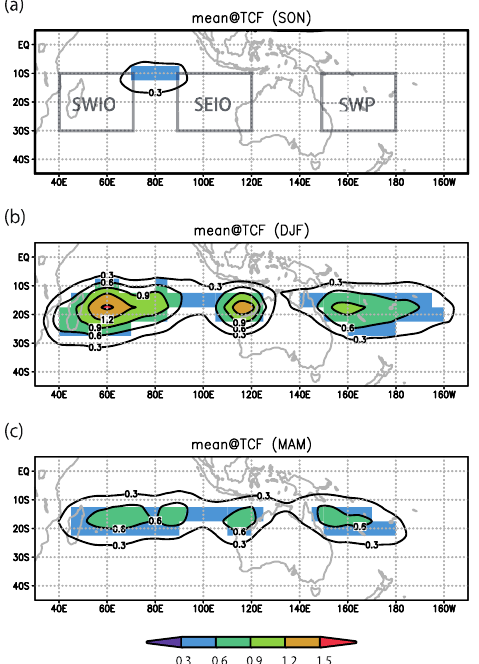
Figure 1. Climatological TCF (defined as occurrence in 5 ◦ × 5 ◦ bins, units are TCs per season) over the SH in ( a ) SON, ( b ) DJF, and ( c ) MAM. More than 0.3 are only